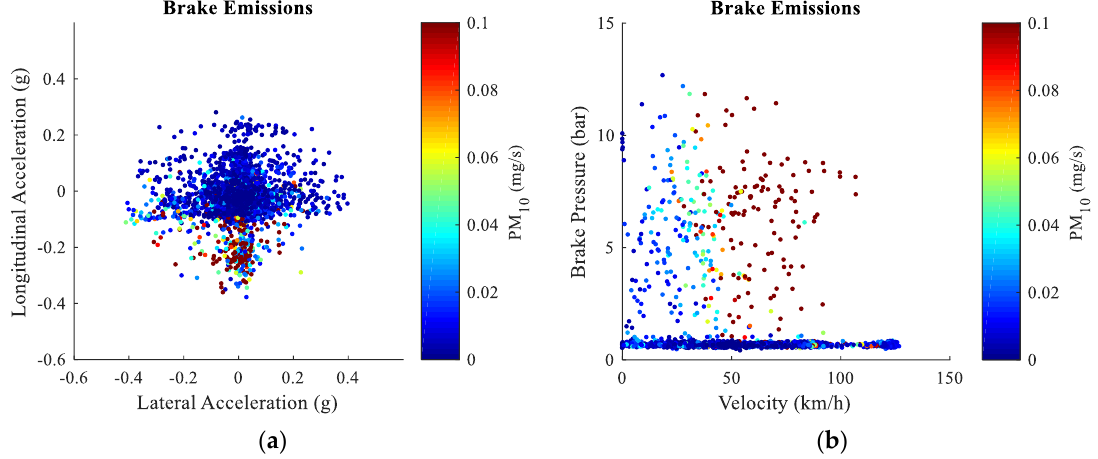
Figure 5. Correlation between vehicle dynamics and particle generation: brake wear emissions as a function of ( a ) vehicle deceleration, ( b ) brake pressure and vehicle speed.